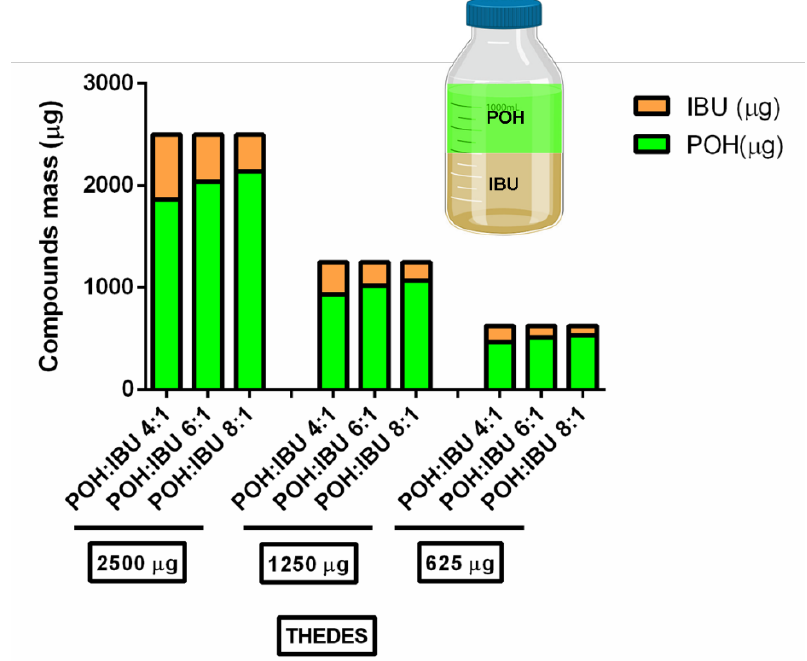
Figure 6. Absolute mass composition of THEDES based on POH and IBU.